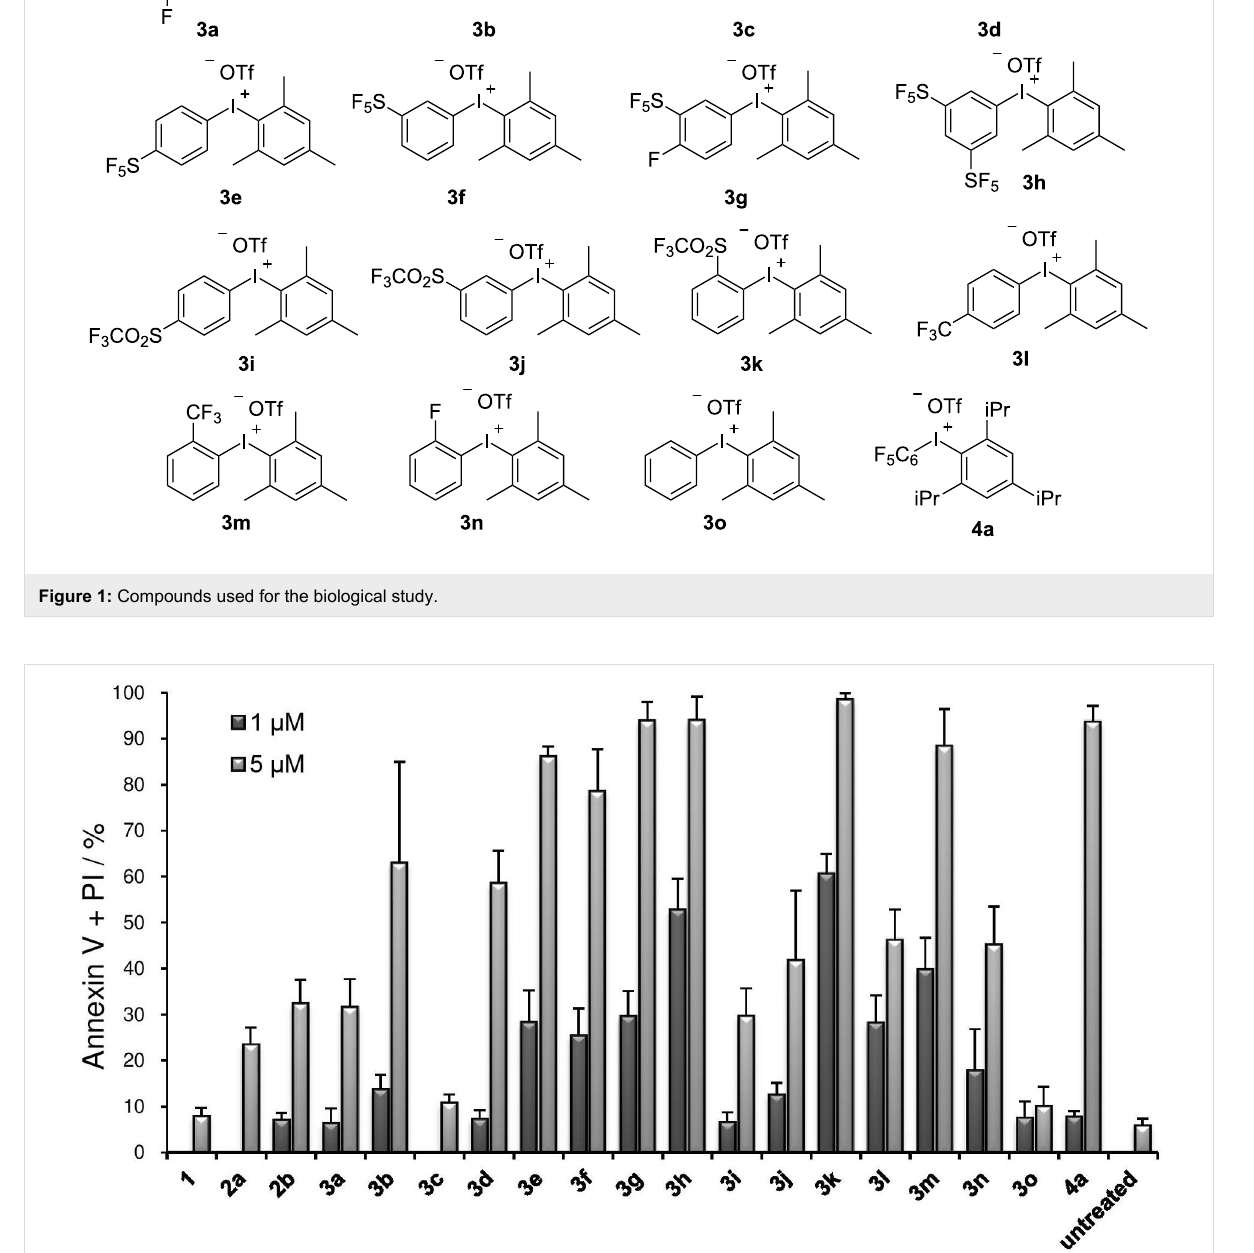
Figure 2: Compounds 1 – 4 induced cell death in U937 cells. Briefly, U937 cells (1 × 10 4 cells/mL) were incubated with each test compound at 1 μ M and 5 μ M for 24 h. Cells were stained with annexin V and propidium iodide (PI). The data shown is the mean ± SD ( n =